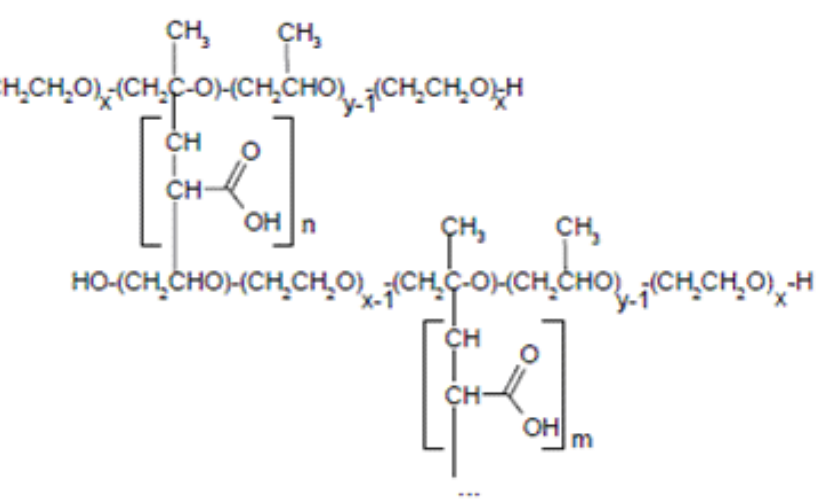
Figure 6. Structure of poly(ethylene oxide)- b -poly(propylene oxide)- b